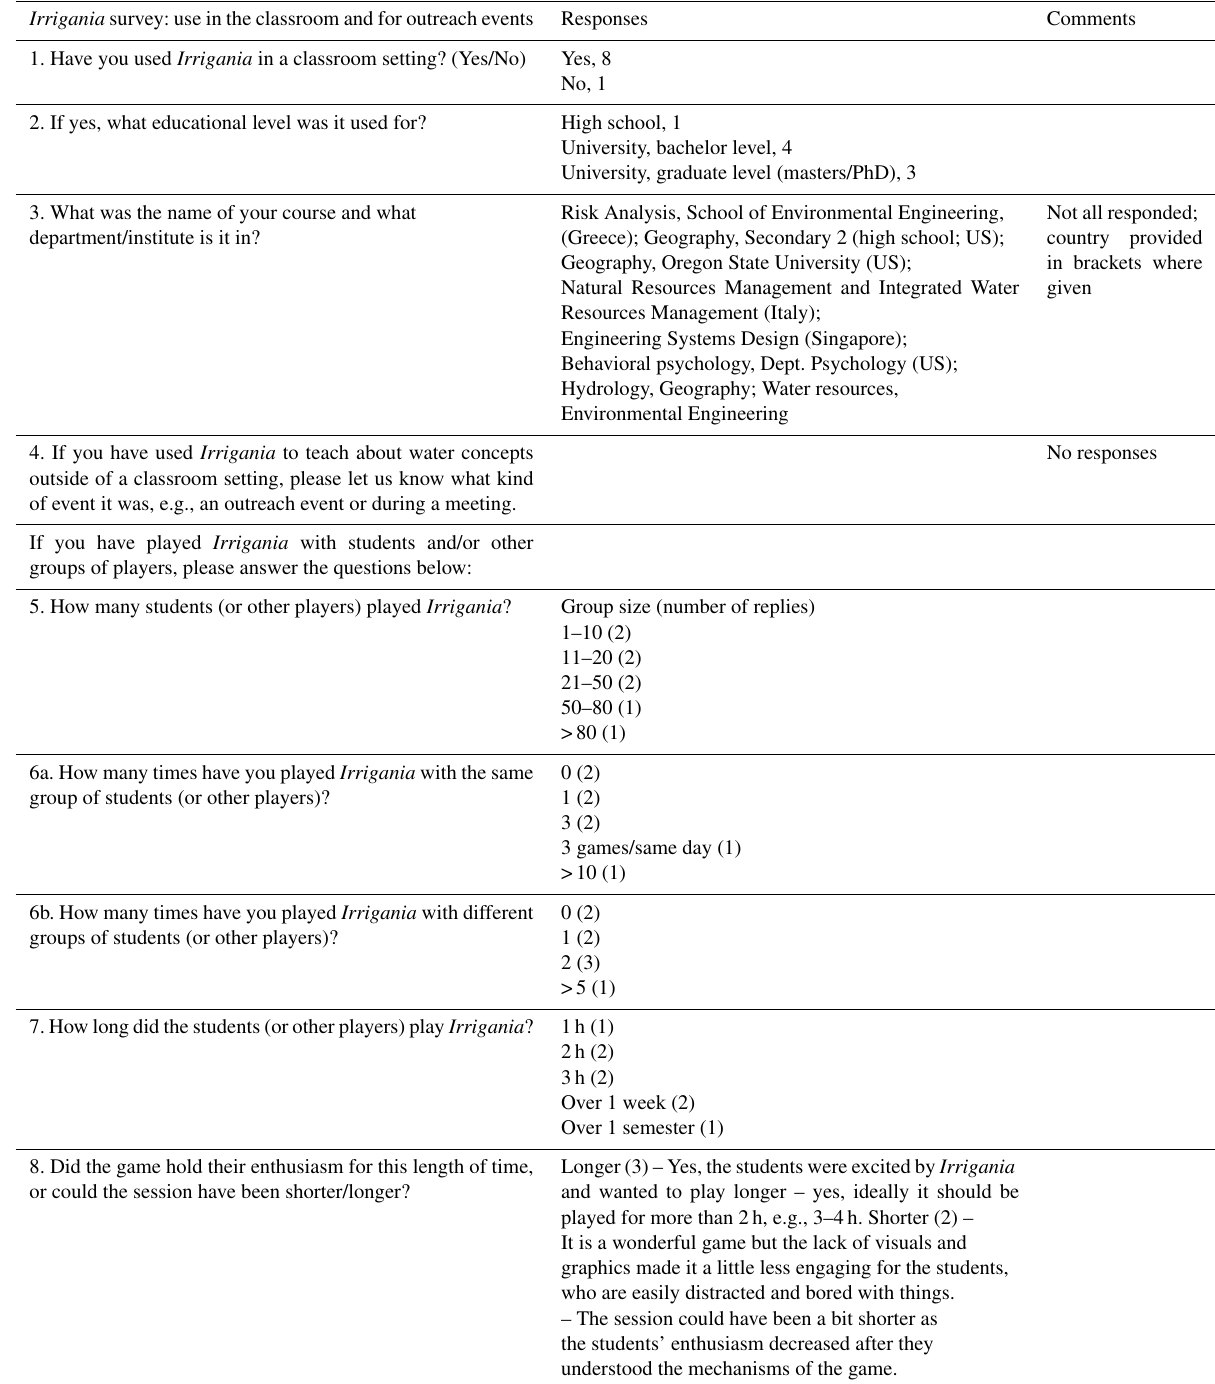
Table A1. The Irrigania survey questions (16, left column) sent out to 18 Irrigania users. A total of nine users responded. Responses are shown for each question, and comments when